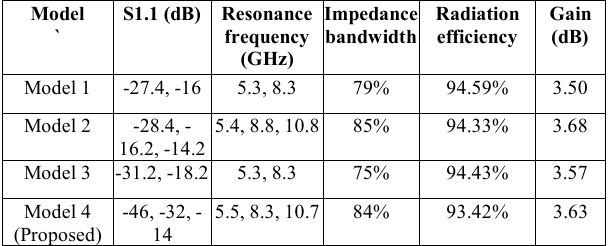
Table 2: Comparison of Proposed Model Based on Various Models.